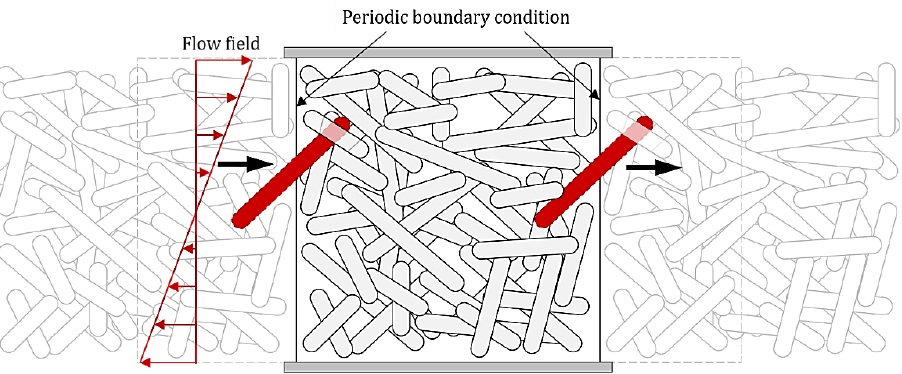
Figure 5. Shear cell with periodic boundary conditions.